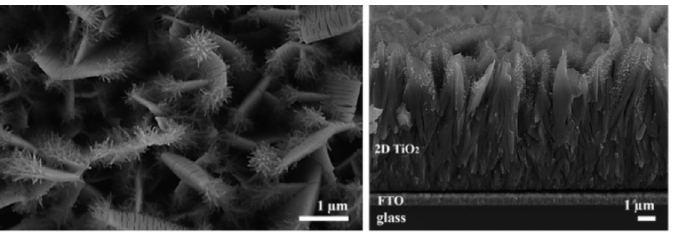
Figure 10. SEM images of branched tubular titania structures. Adapted with permission from [184], Copyright 2018, Wiley.